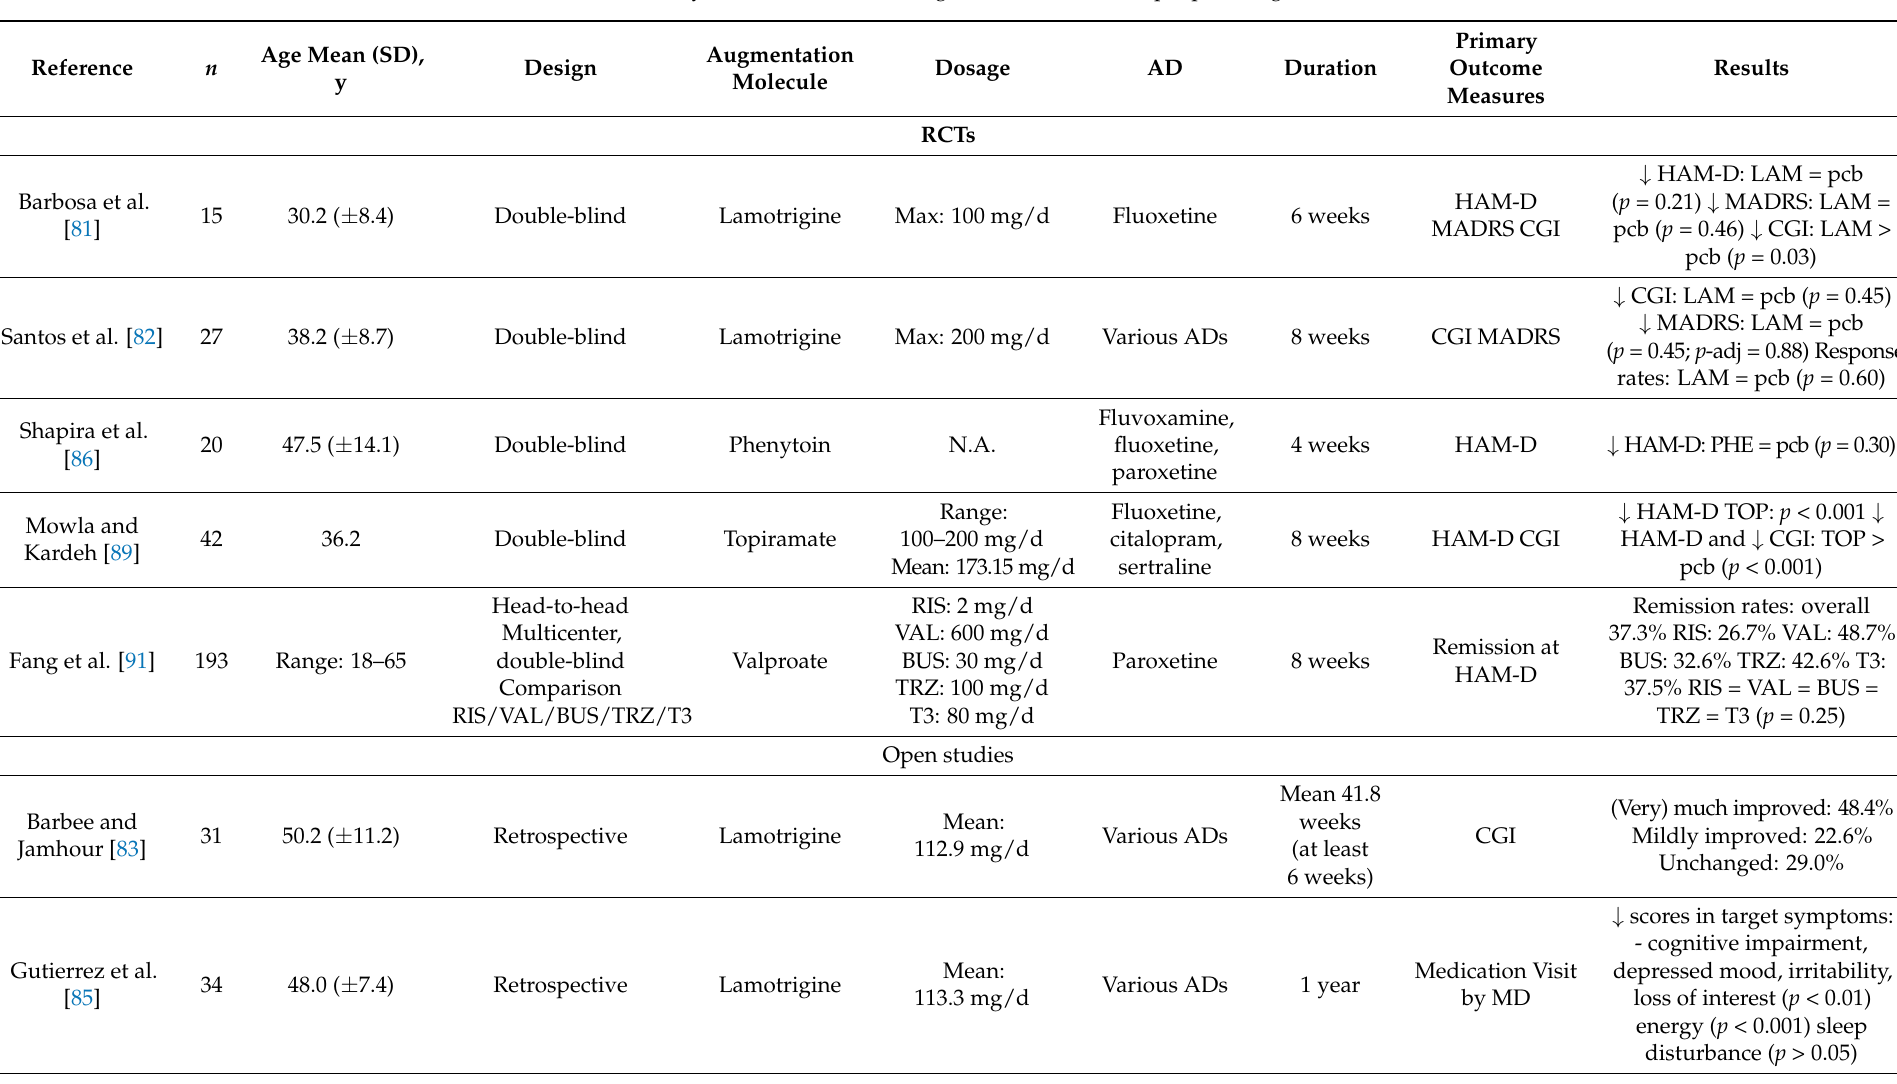
Table 4. Summary of the studies about augmentation with antiepileptic drugs in